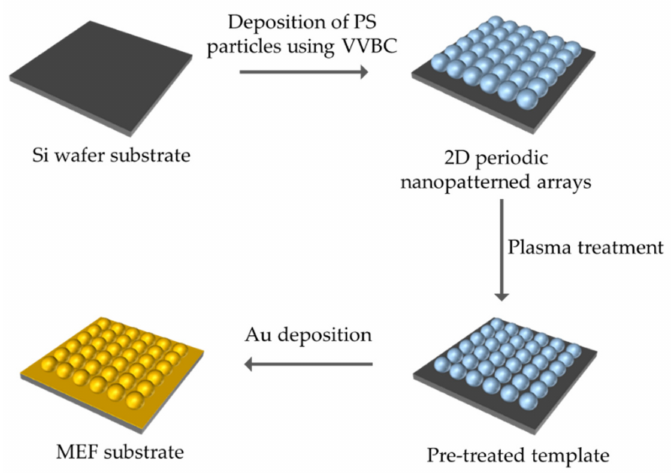
Figure 3. Schematic illustration of the MEF substrate